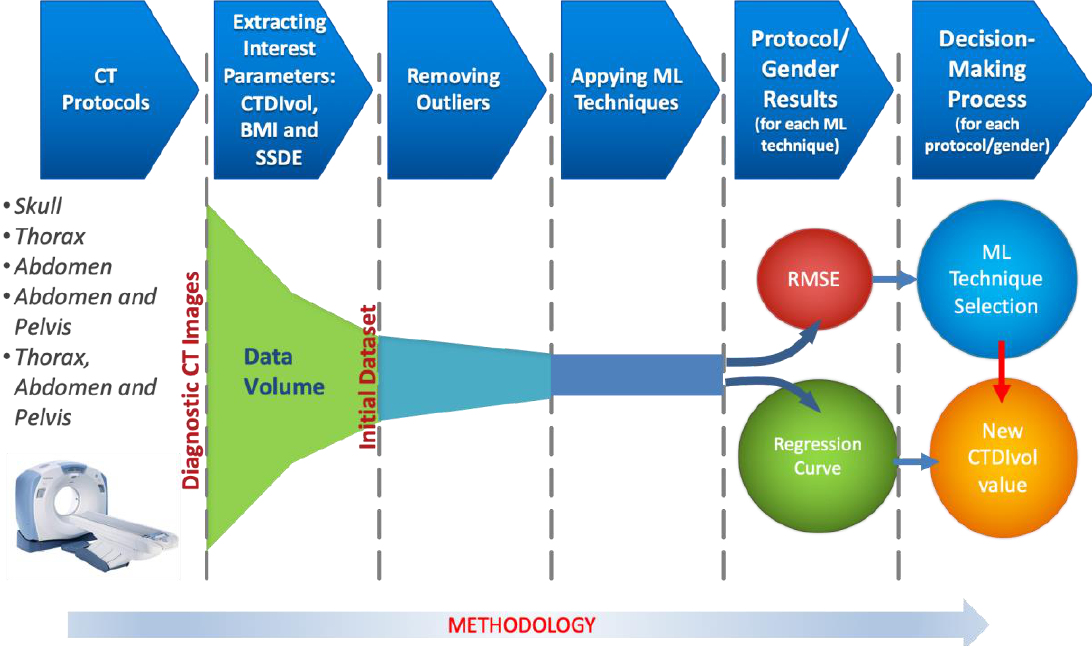
Figure 1. Methodology to predict future doses in patients radiated by CT.